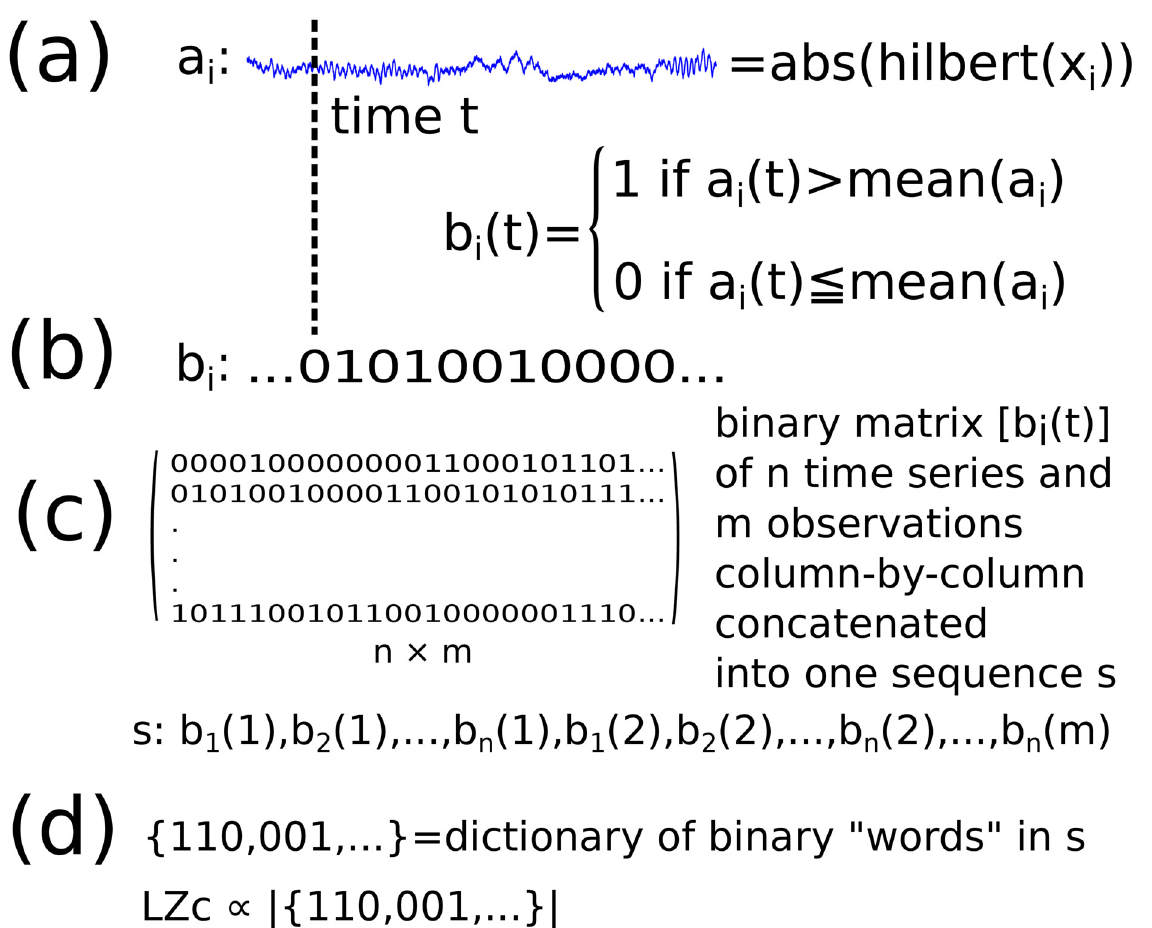
Fig 3. Schematic of the computation of Lempel-Ziv complexity LZc. a) x i is the activity of the i th EEG electrode, i.e. the i th channel, and a i is the (Hilbert) amplitude of x algorithm. d) Lempel-Ziv complexity LZc is proportional to the size of this